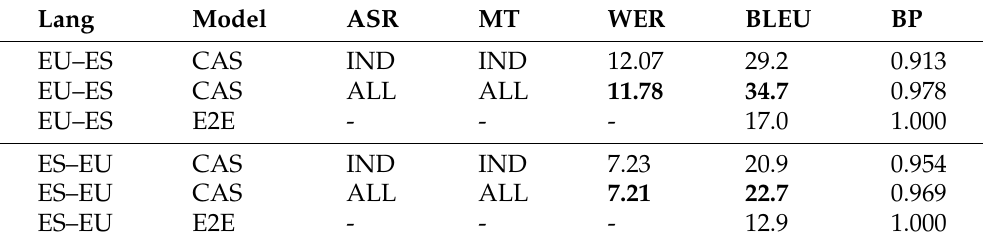
Table 9. Results on cascade and end-to-end baseline models. The best results, indicated in bold, are statistically significant against all other results, for p <